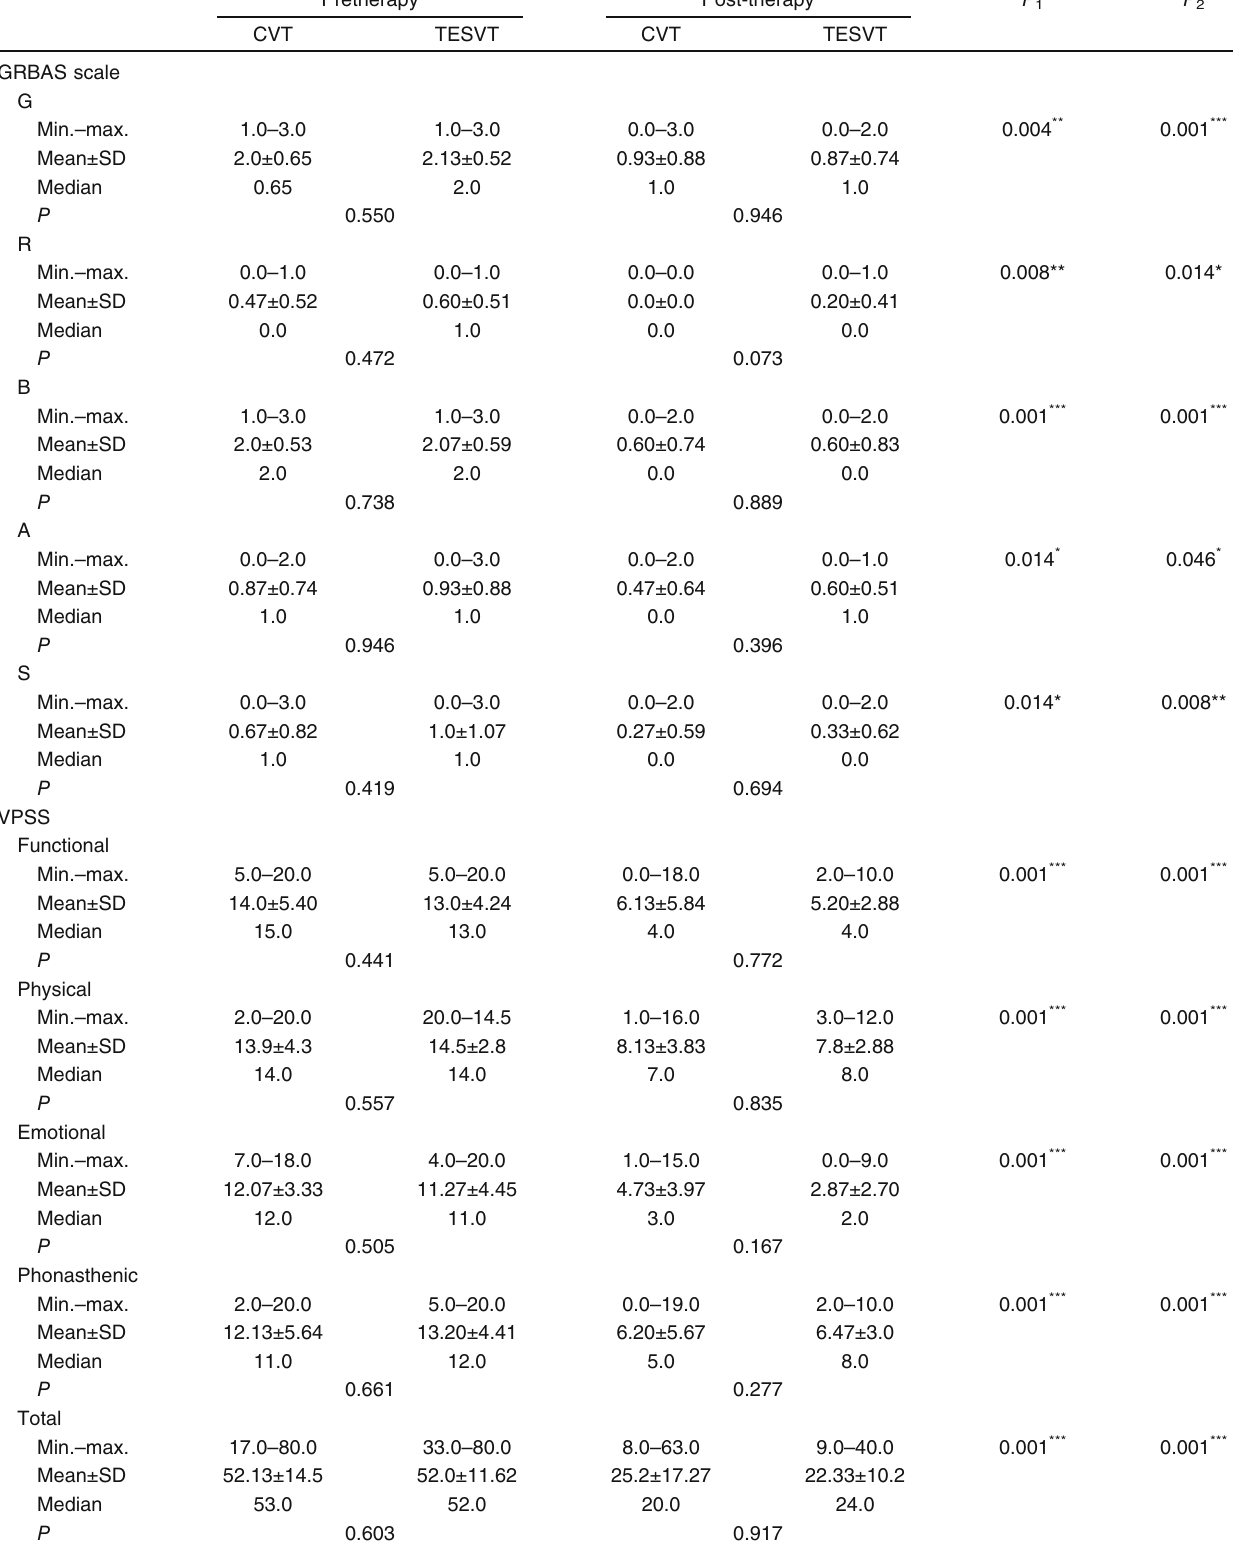
Table 2 The auditory perceptual assessment using the GRBAS scale for the two studied groups before and after therapy and patient ’ s self-evaluation of dysphonia using the Voice Problem Self-assessment Scale Pretherapy Post-therapy P 1 P 2 CVT TESVT CVT TESVT GRBAS